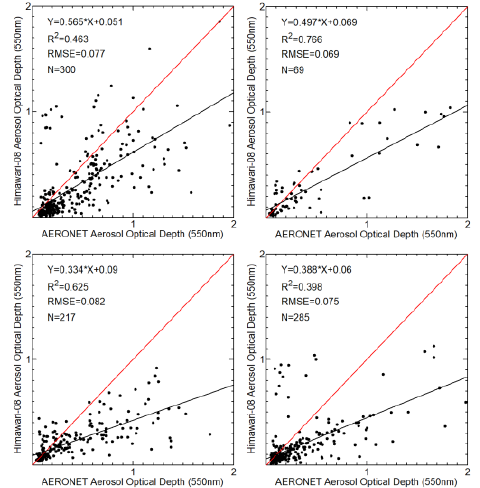
Figure 2. Scatter plots of Himawari-08 AODs versus AERONET AODs in